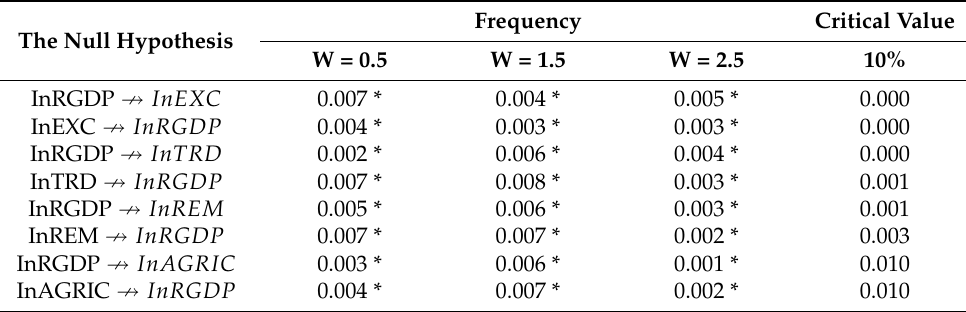
Table 3. Results of the panel frequency